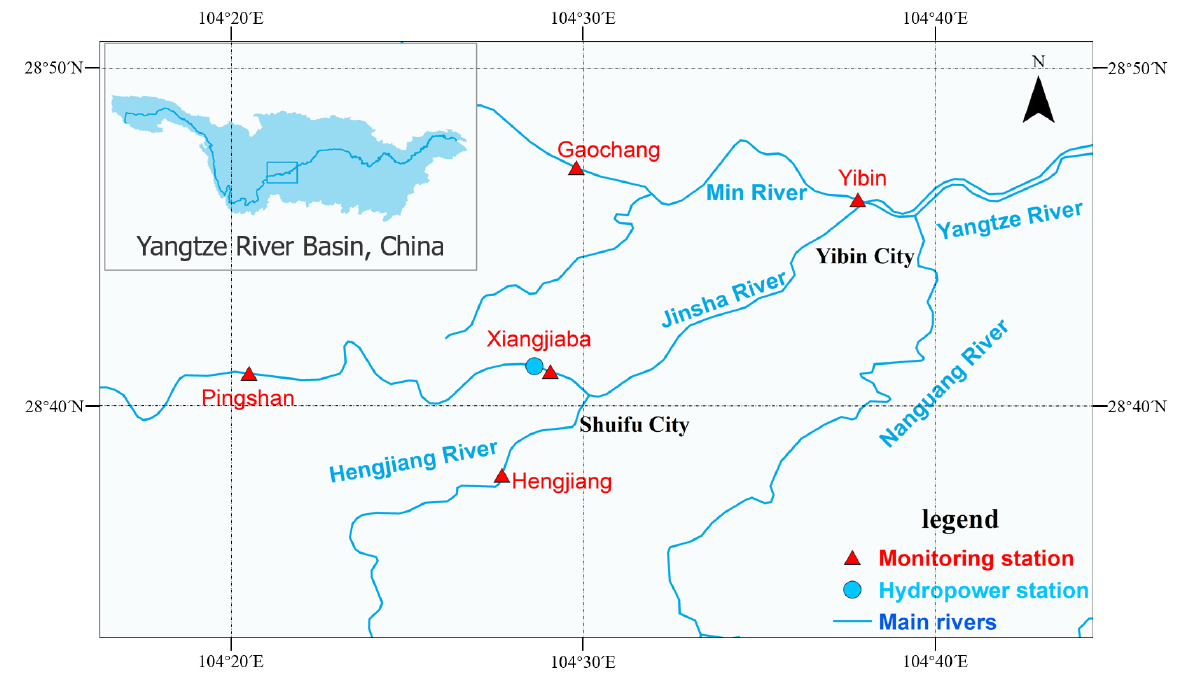
Figure 1. Distribution map of main dams (blue circle) and hydrological monitoring points (red triangles) in the study